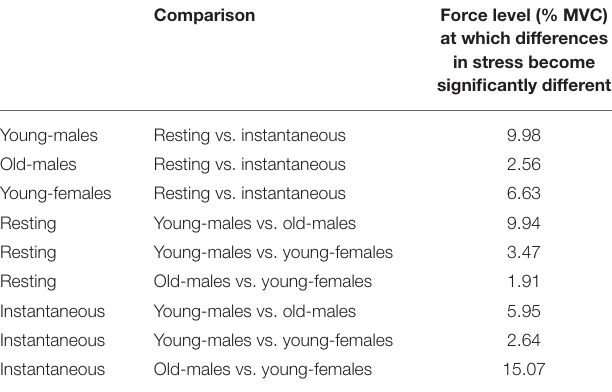
TABLE 2 | Johnson–Neyman regions of